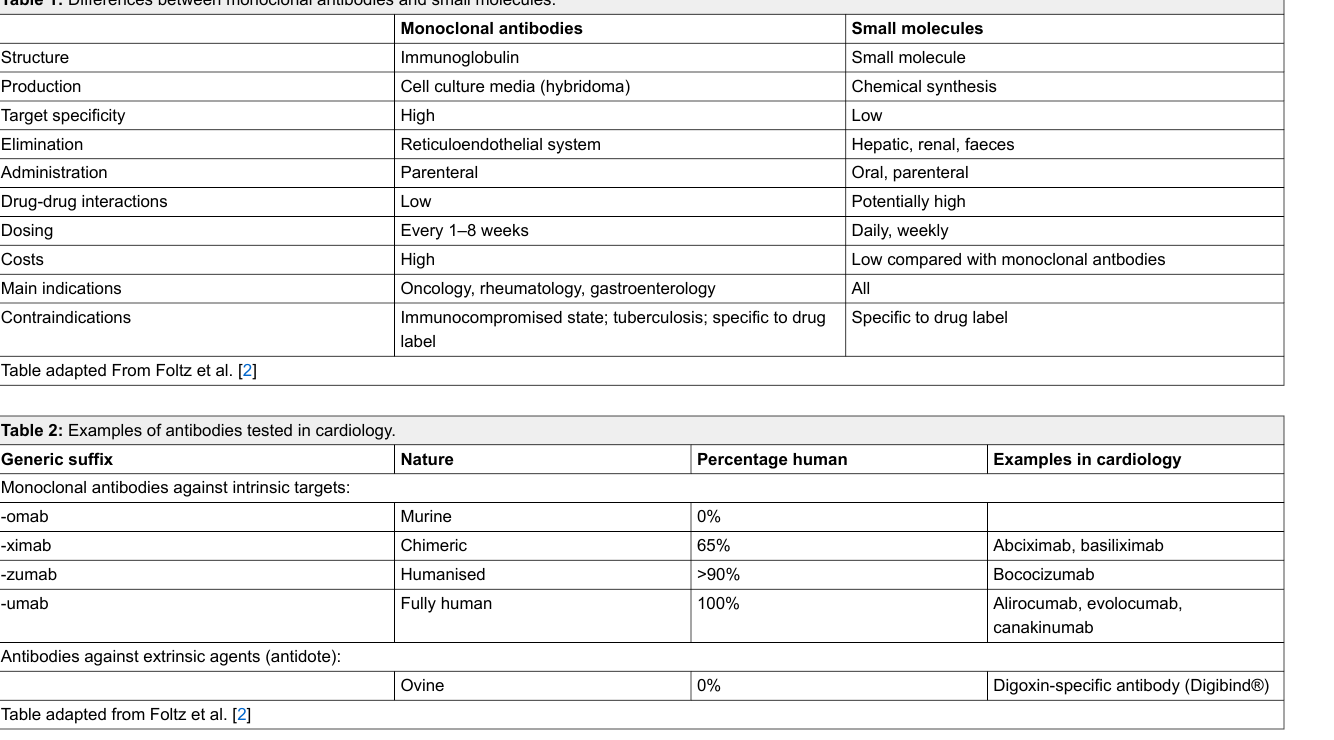
Table 1: Differences between monoclonal antibodies and small molecules.